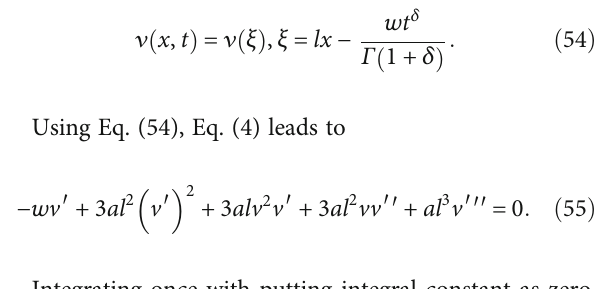
gularities. Figure 1 represents topological kink-dark bell ð x , t Þ . It is signi fi ed that the e ff ect of order waves of ν 1